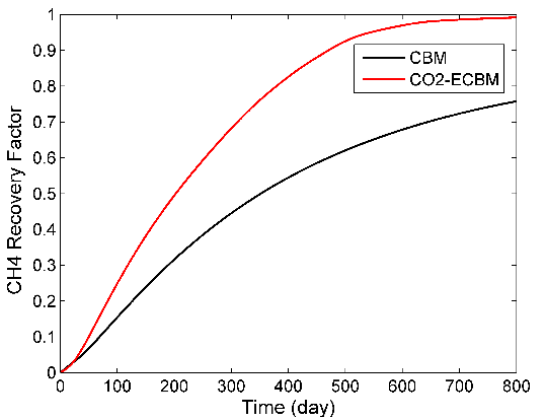
Figure 12. Comparison of field CH 4 production rate for CBM and CO 2 -ECBM.